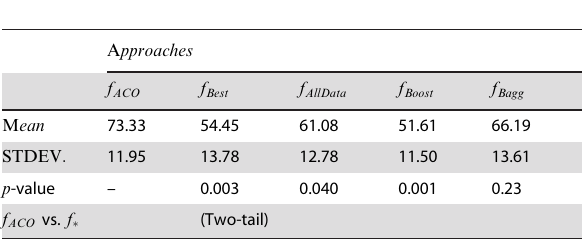
Table 7. Experimental results for HD prediction problem. Accuracy percentage values of ACO and Benchmark